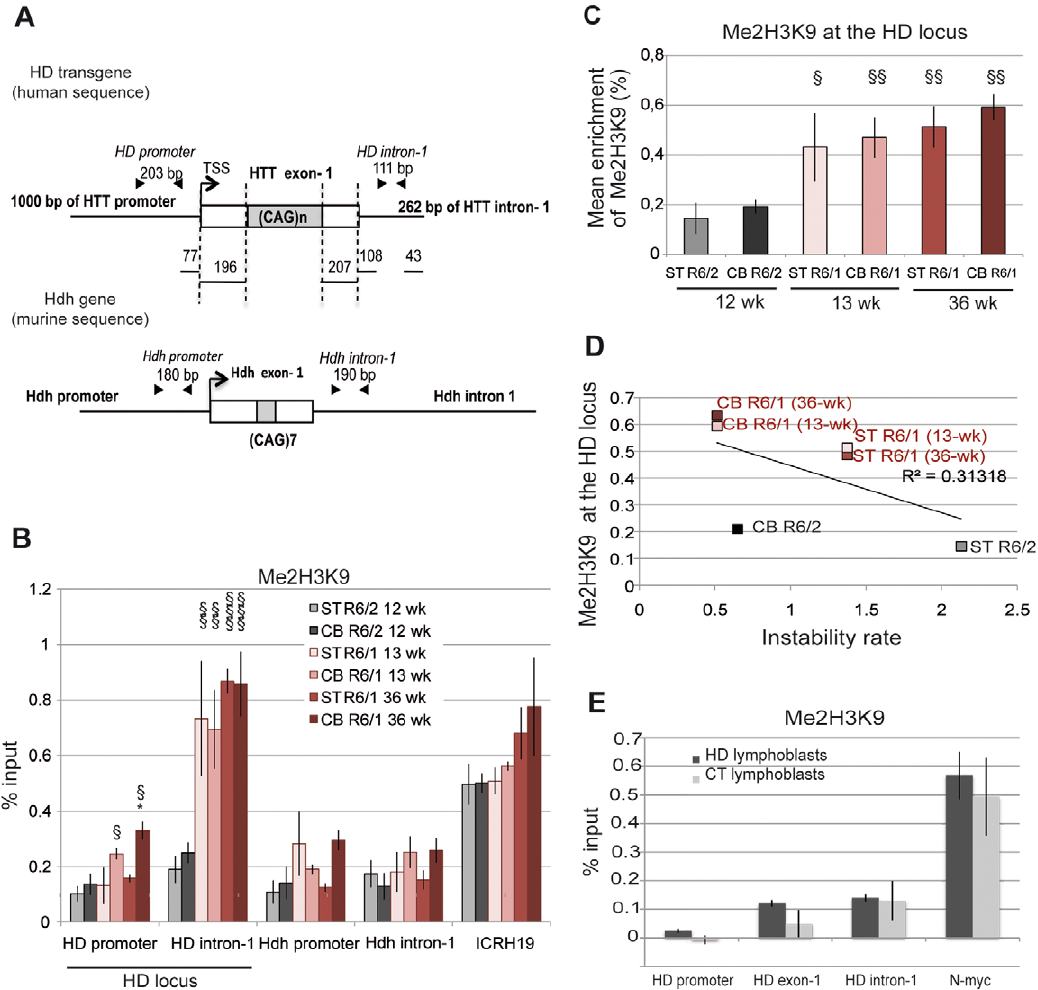
Figure 2. Me2H3K9 at the HD locus in R6/1 and R6/2 striatum and cerebellum. A. Schematic representation of the human HD transgene expressed in R6 mice and of the corresponding region in Hdh . The arrows show locations of the primers used to assess chromatin structure. B. ChIP analysis from the striatum (ST) and the cerebellum (CB) of R6/1 and R6/2 mice using antibody to Me2H3K9. R6/1 mice at early- and/or late- pathological stages (13- and 36-wk) and R6/2 mice at late-pathological stage (12-wk) were used. Error bars, sem; *, inter-tissue comparisons; 1 , inter- mouse line comparisons. *, p , 0.05; 1 , p , 0.05; 11 , p , 0.01, 111 , p , 0.001. C. Global analysis of the level of Me2H3K9 at the HD locus. The mean levels of Me2H3K9 at the HD locus, corresponding to mean ChIP values at the HD promoter and HD intron-1, were calculated for the striatum and cerebellum of R6/1 mice at early and late-pathological stages (13- and 36-wk) and for the striatum and cerebellum of R6/2 mice at late pathological stage (12-wk). Error bars, sem; 1 , p , 0.05; 11 , p , 0.01. D. Correlative analysis of CAG instability rates with mean levels of Me2H3K9 at the HD locus. R6/ 1 mice of 13 and 36 weeks and R6/2 mice of 12 weeks were used for correlation analysis E. ChIP analyses of the HD locus from lymphoblast cell lines derived from HD patients and control individuals (CT), using antibody to Me2H3K9. The values correspond to mean values calculated from ChIP performed from 4 HD cell lines and 2 control cell lines.